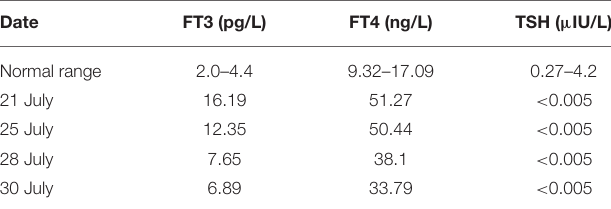
TABLE 1 | Laboratory parameters of thyroid function (FT3, FT4, and TSH).